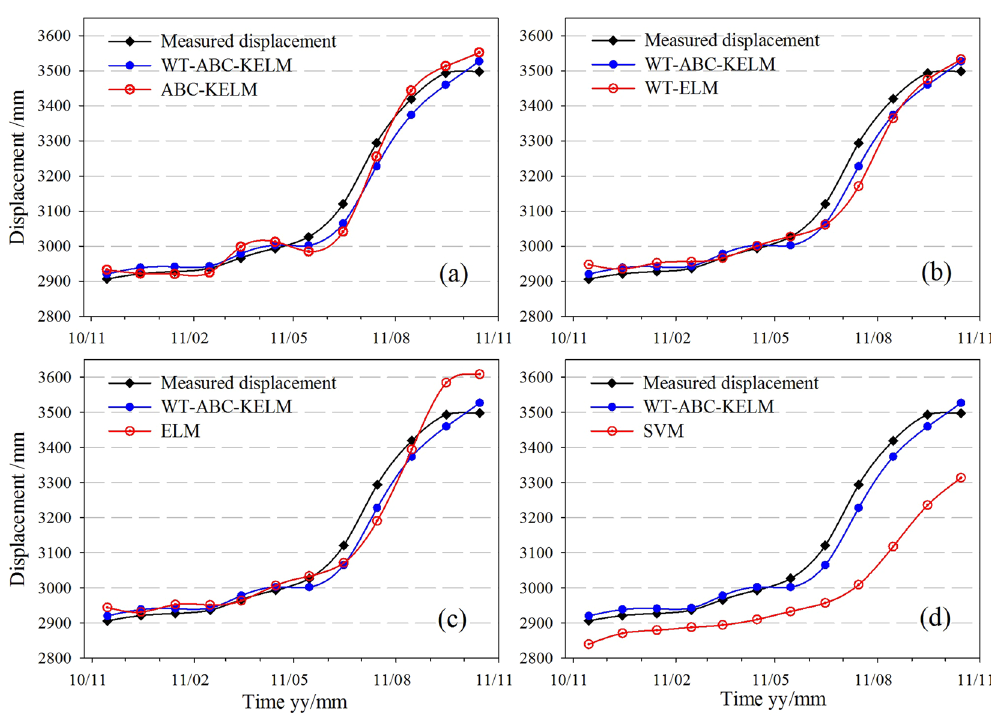
Figure 9. The predicted results of the compared methods: ( a ) ABC-KELM, ( b ) WT-ELM,( c ) ELM, and ( d )